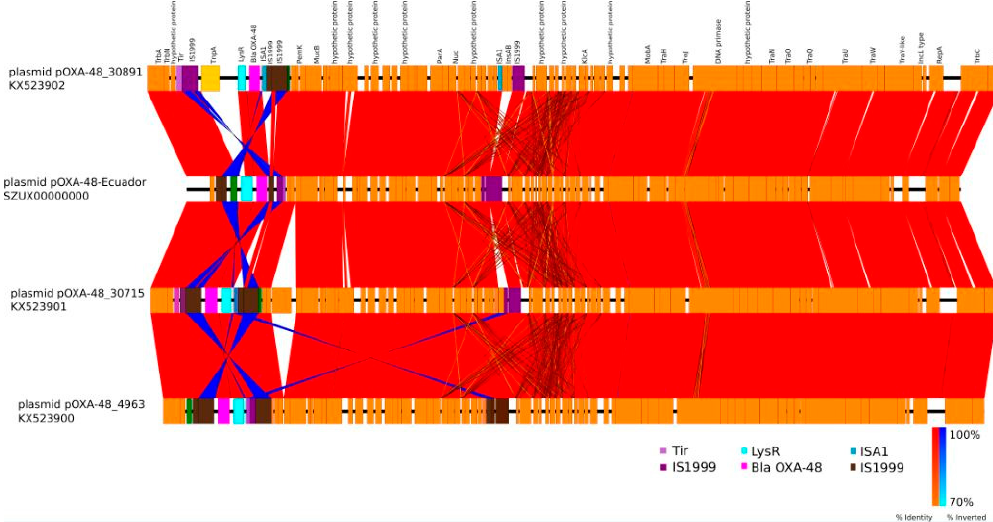
Figure 2. Plasmid OXA-48 of K. pneumoniae of Ecuador. Whole sequence shows a high degree of identity with plasmids from Czech